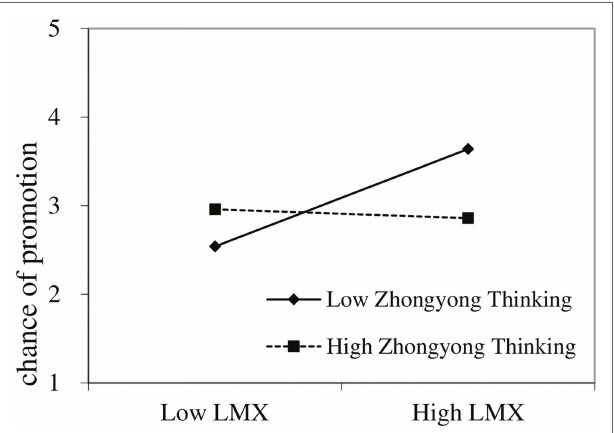
FIGURE 3 | Moderating role of Zhongyong thinking (ZYT) in the relationship between leader-member exchange (LMX) and chance of